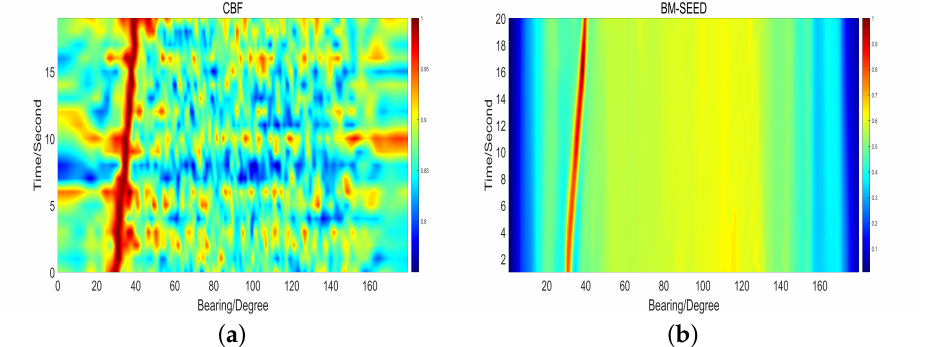
Figure 8. Experiment Results under − 26 dB SNR. ( a ) CBF result under − 26 dB SNR; ( b ) BM-SEED result under − 26 dB SNR.